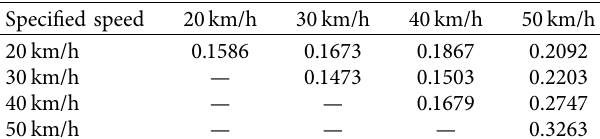
Figure 6: Lateral offset of driver 1 and driver 3. Table 2: Similarity LCSS of lane-changing trajectory for skilled drivers.